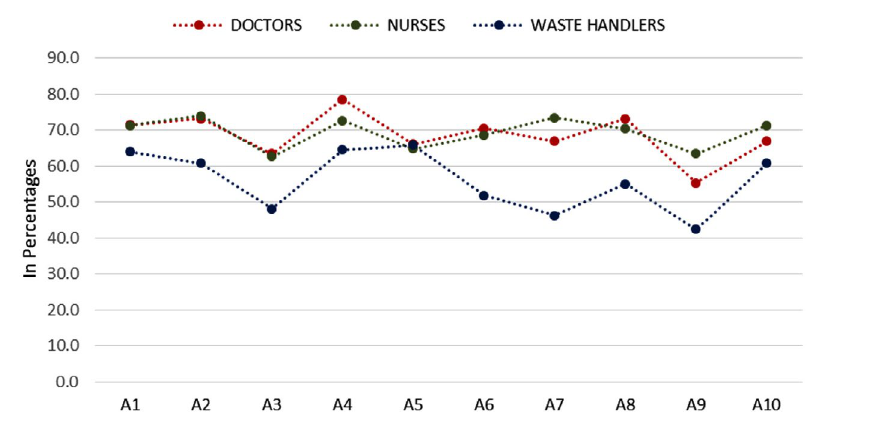
Fig. 1. Level of BMWM awareness among health care personnel.